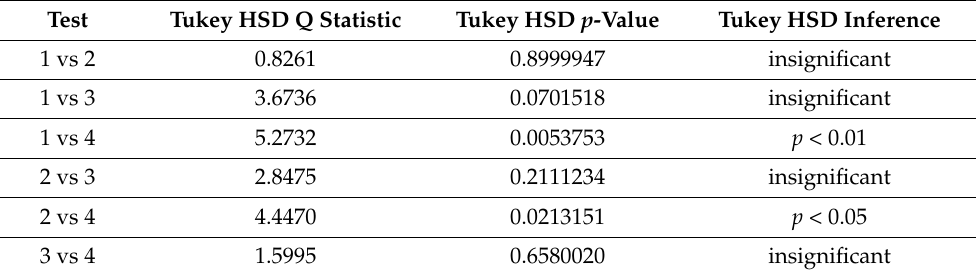
Table 9. Oculomotor SSQ score Tukey HSD